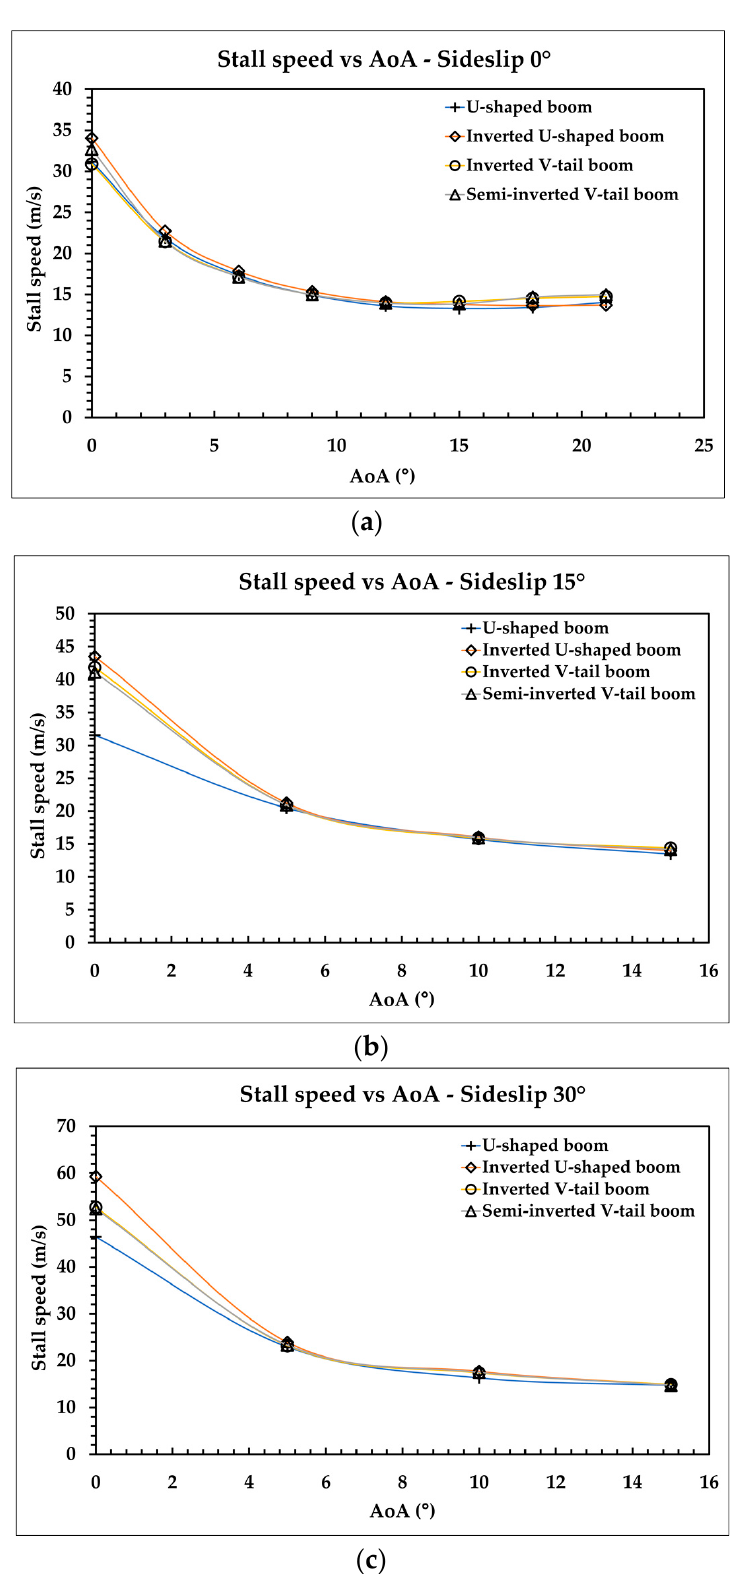
Figure 13. Stall speed vs. AoA, sideslip angle: ( a ) 0°, ( b ) 15°, and ( c ) 30°.